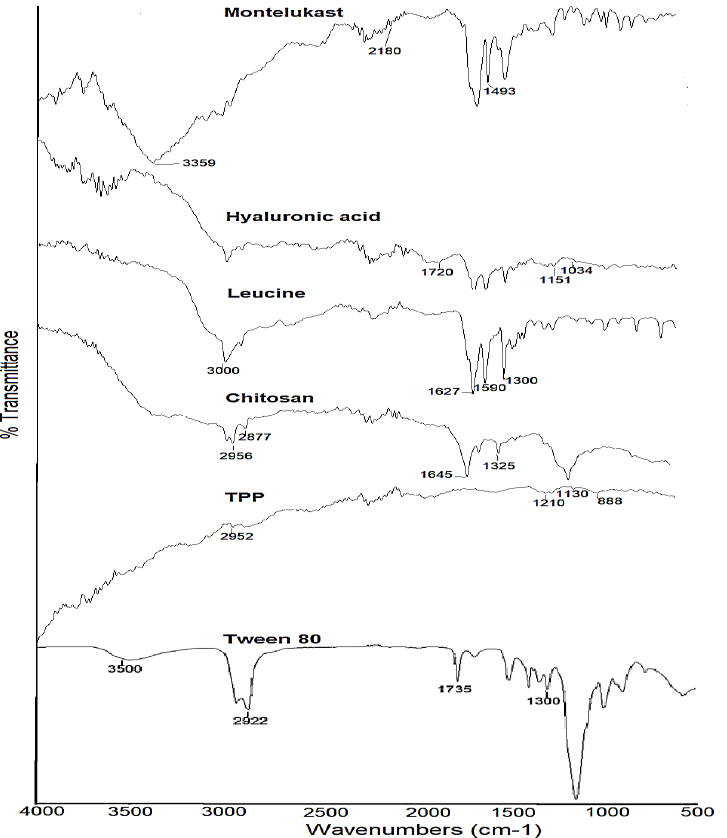
Figure 3. FTIR spectra of raw montelukast, chitosan, hyaluronic acid, TPP, leucine and Tween 80. The FTIR spectra of selected formulations (F2, F4, F5 and F6) with the encapsulated drug are shown in Figure 4. The characteristic peaks of montelukast at 3359 cm −1 and 2180 cm −1 , as well as 1560 cm −1 and 493 cm −1 , are well preserved in F2, F4 and F6. In the case of F5, the spectral bands had been masked due to hyaluronic acid (Figure 4).